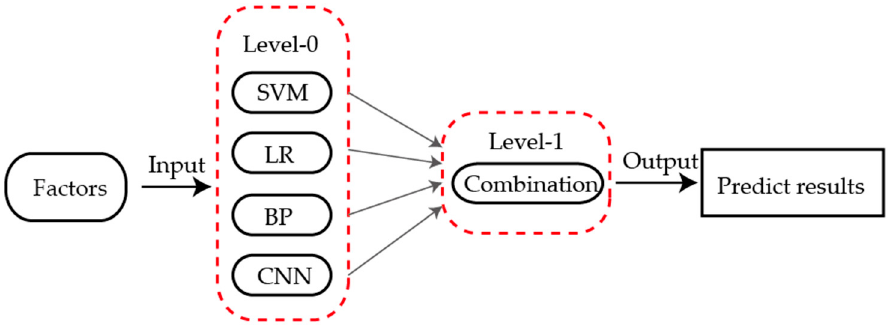
Figure 3. Schematic diagram of ensemble learning.